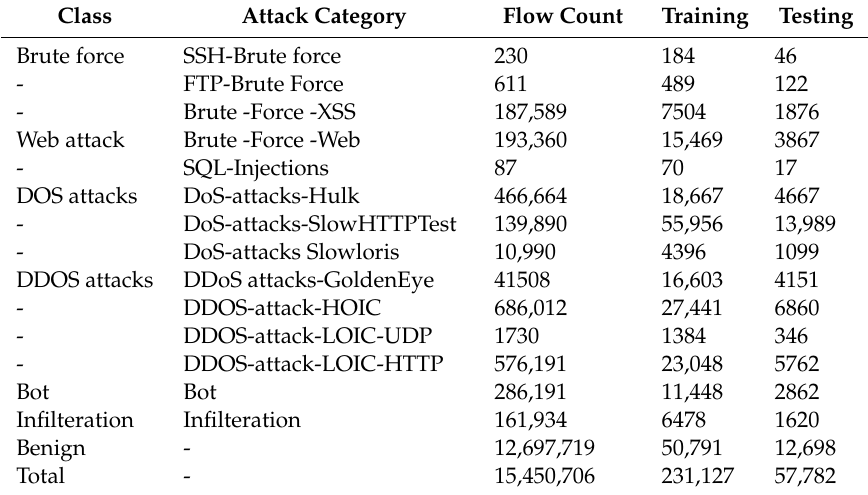
Table 3. Training and testing data distribution.